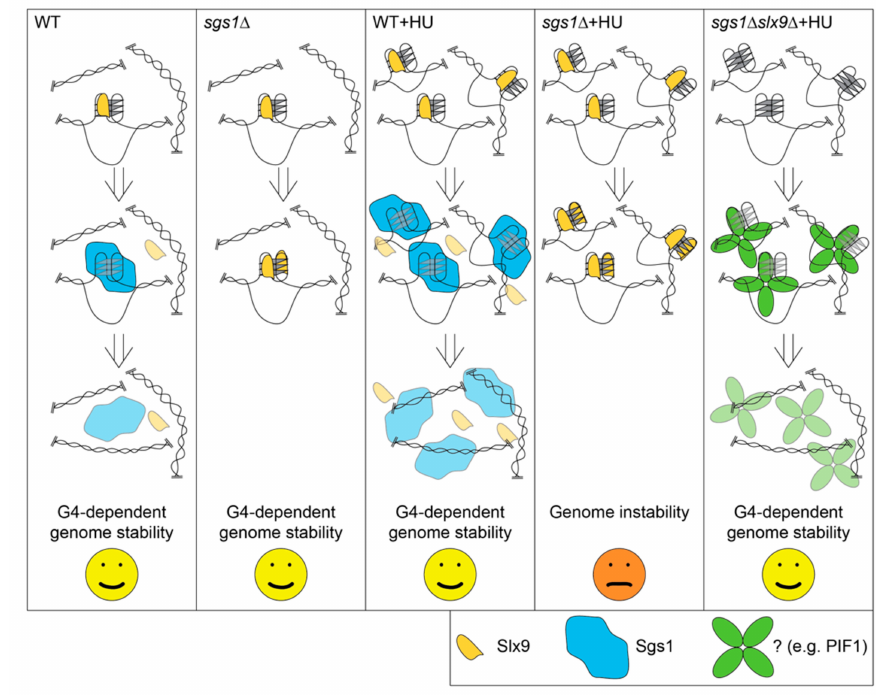
Figure 4. Model detailing how Slx9 recognizes folded G4